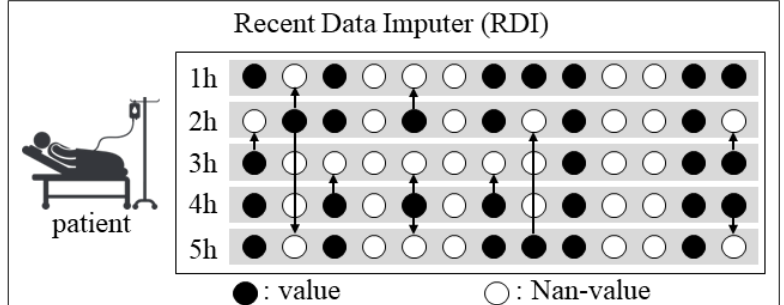
Figure 2. Processing by the recent data imputer (RDI). The black nodes indicate measured values and the white nodes indicate missing values.